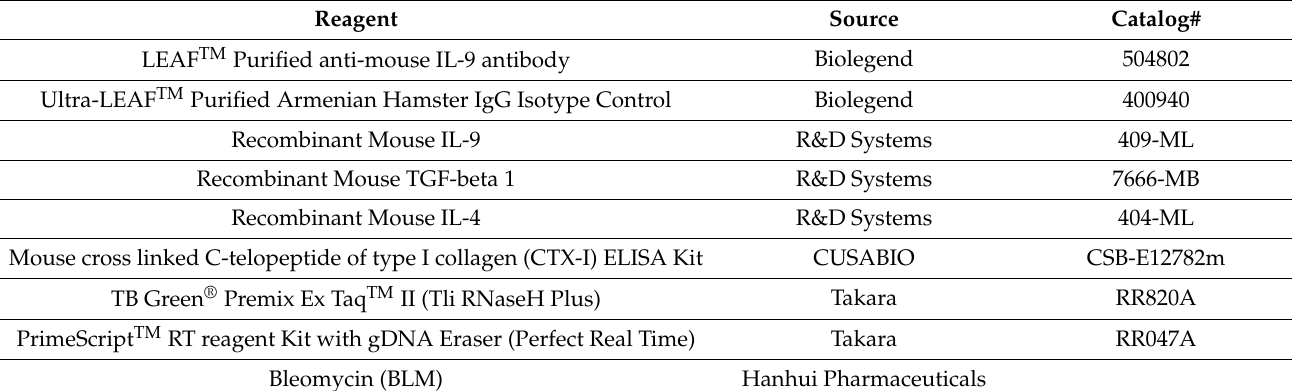
Table 3. Reagent